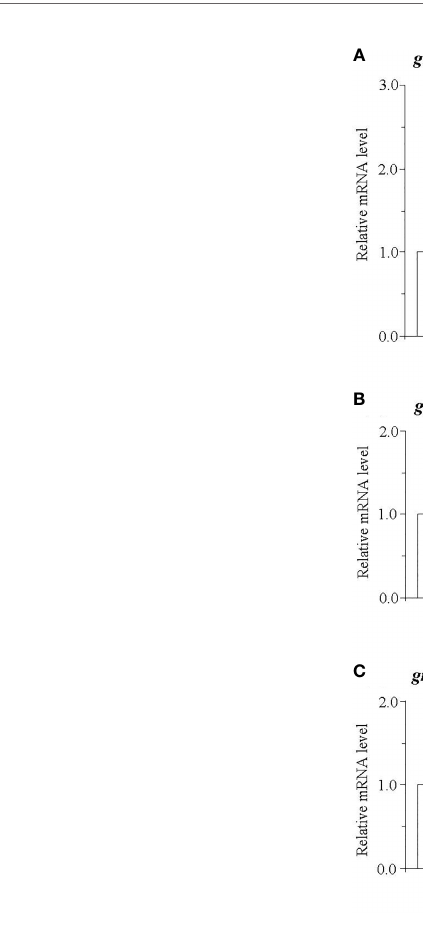
FIGURE 3 | Changes in the relative mRNA levels of gnrh1 (A) , gnrh2 (B) and gnrh3 (C) in the brain of grass puffer at immature and mature stages after intraperitoneal injection of gpKiss2 for the period of 12hrs. Values are presented as mean ± SEM (n = 6 − 8). Values accompanied by different letters are statistically signi fi cantly different ( p < 0.05).